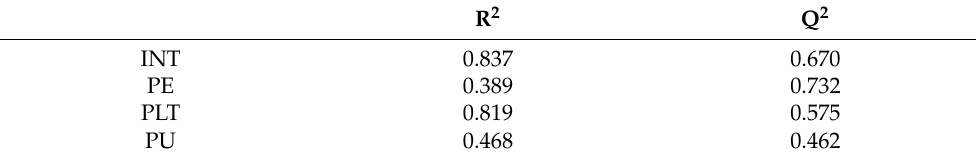
Table 8. Coefficient of determination (R 2 value) and predictive relevance (Q 2 value).